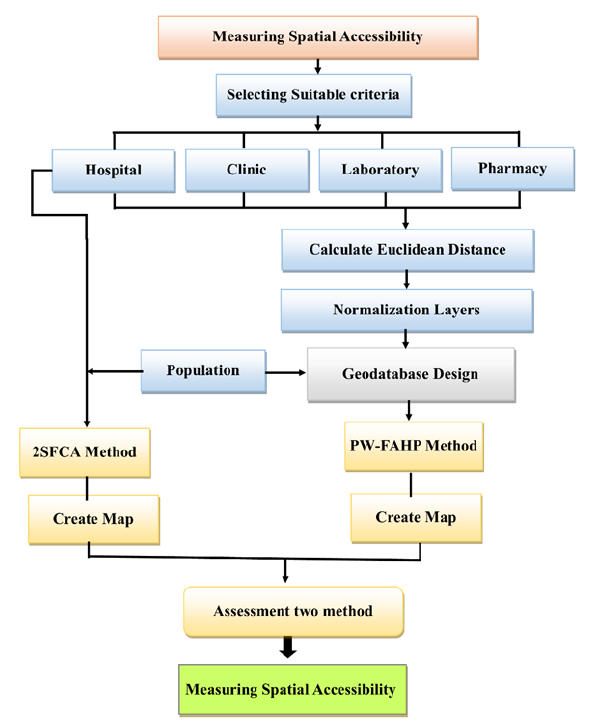
Figure 4. An overview of the proposed methodology and